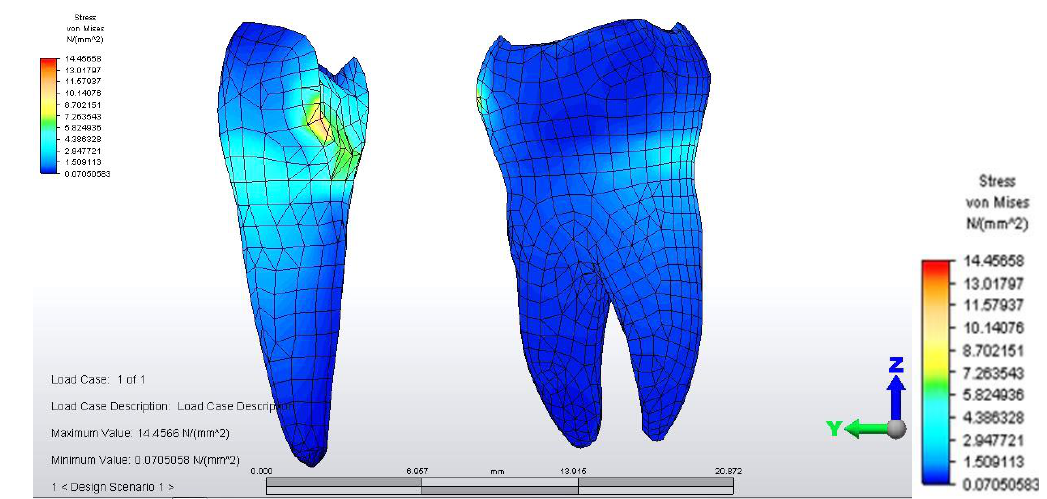
Figure 5. Tension distribution at the abutments level in three directions: axonometric, right and left when the force is placed in the 3.5 area.